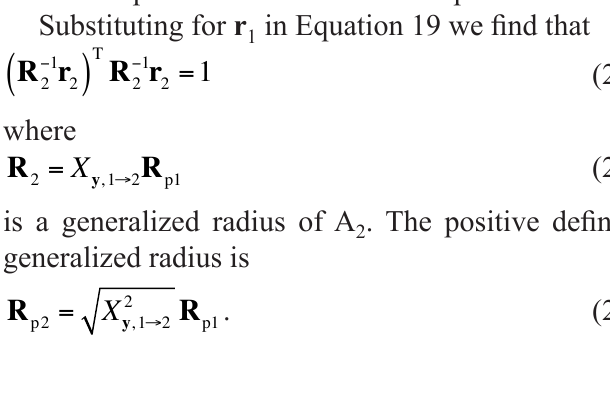
Figure 2 An ellipse E in a transverse plane T. a is half the ma- jor diameter and b half the minor diameter. v vectors along the major and minor diameters respectively. Z is the longitudinal axis and is orthogonal to the plane of the paper. Relative to Z the centre of the ellipse has position vector y 0 . y is the position vector of a point on the ellipse. r = y − y 0 is the position vector of the point relative to the centre of the ellipse; it is a radial vector of the